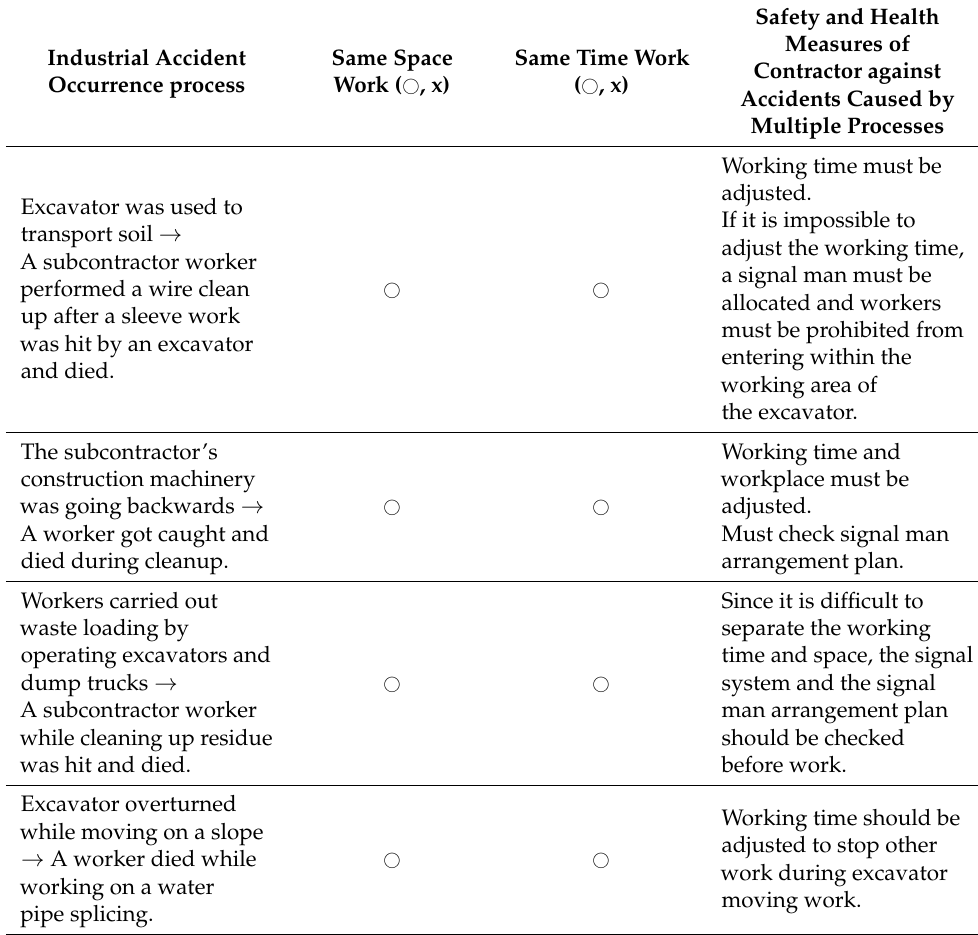
Table 7. Cases of collision accidents by multiple processes in the